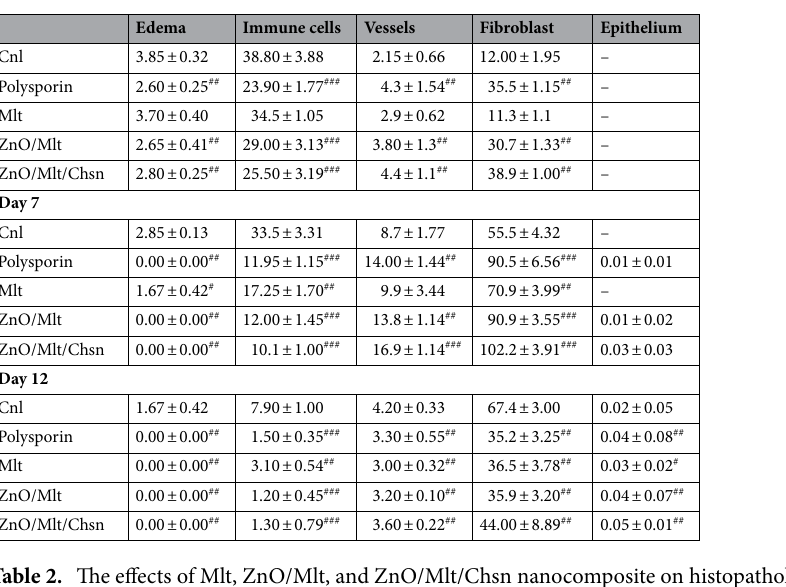
Table 2. The effects of Mlt, ZnO/Mlt, and ZnO/Mlt/Chsn nanocomposite on histopathological parameters. The superscripts (#) show groups have significant differences ( P < 0.05 ) on same sampling